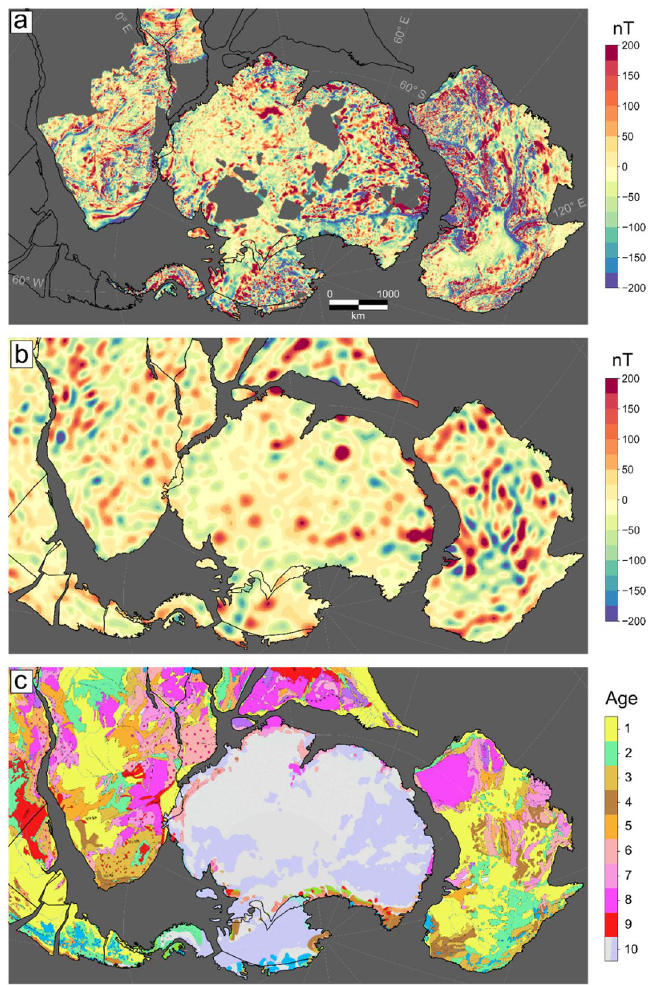
Figure 1. ( A ) Conformed aeromagnetic data, ( B ) Satellite model LCS-1 after variable reduction to the pole, represented at 5 km ellipsoidal height. ( C ) Surface geology as represented in the Geological Map of the World 28 . The geological units are: 1: Cenozoic, 2: Mesozoic, 3: Upper Paleozoic, 4: Lower Paleozoic, 5: Neoproterozoic, 6: Mesoproterozoic, 7: Paleoproterozoic, 8: Archean, 9: Large Igneous Provinces, 10: Glaciers and Ice. For more details, see 28 . All data sets are rotated back to 200 Ma with the deformable plate model 5